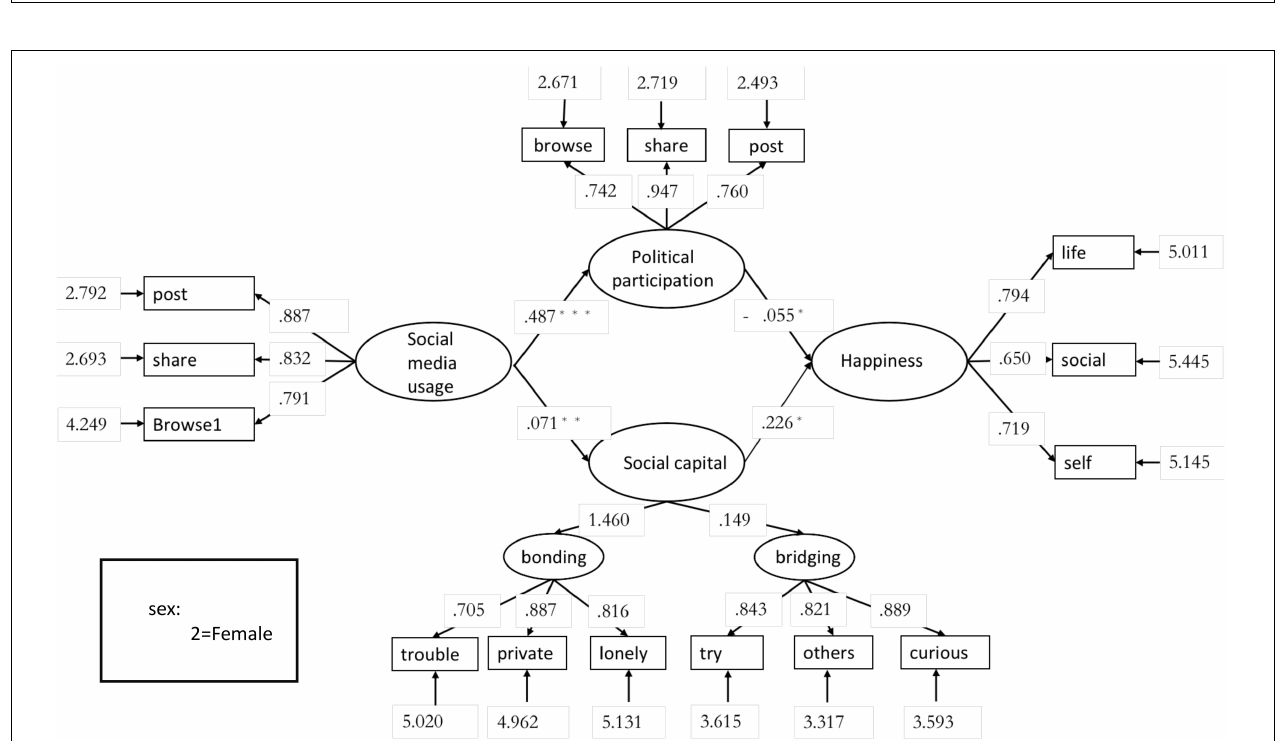
FIGURE 2 | Structural equation model of the relationship between frequency of social media use, online political participation, social capital, and well-being. *** means p < 0 . 001, **means p < 0 . 01, *means p < 0 . 05.